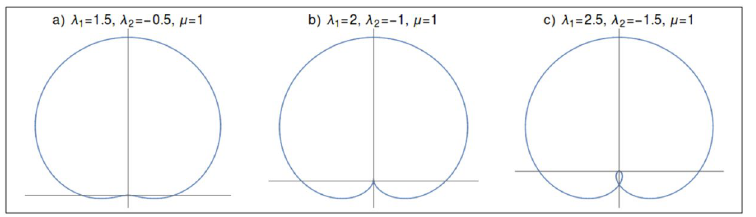
(cid:31) µ 1 . ( a ) Trivial gapless phase ( b ) = −